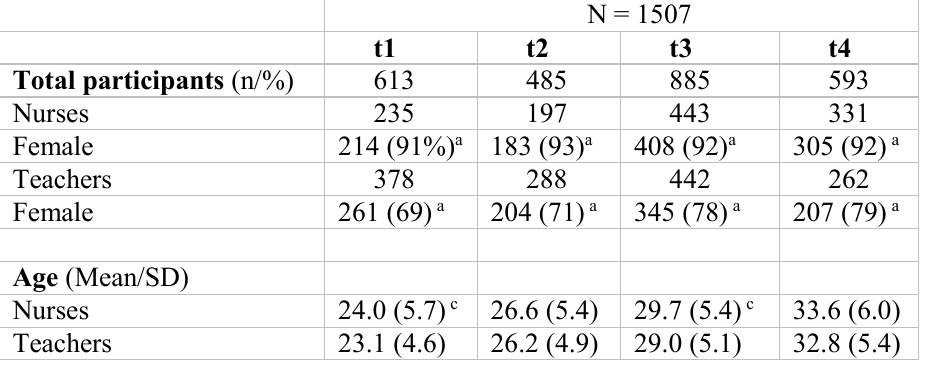
Demographic data for gender and age